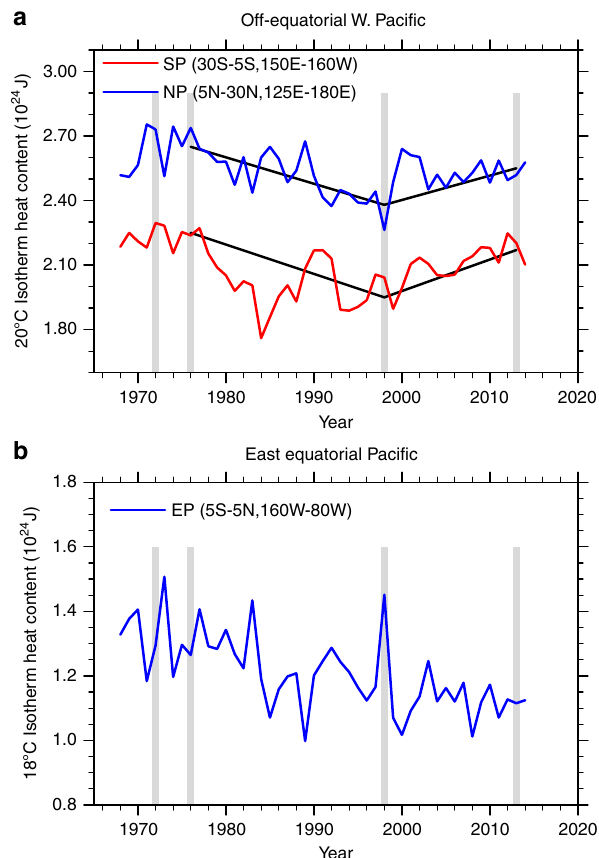
Figure 1 | Off-equatorial western Pacific and east equatorial Pacific heat content. ( a ) Annual mean time series of vertically integrated ocean heat content ( (cid:2) 10 24 J) to the depth of the 20 (cid:2) C isotherm for regions in the off- equatorial western Pacific from the ocean initial states used for the initialized model hindcasts; blue line for an area in the northwest tropical Pacific (5 (cid:2) N–30 (cid:2) N, 125 (cid:2) E–180 (cid:2) E); red line for an area in the southwest